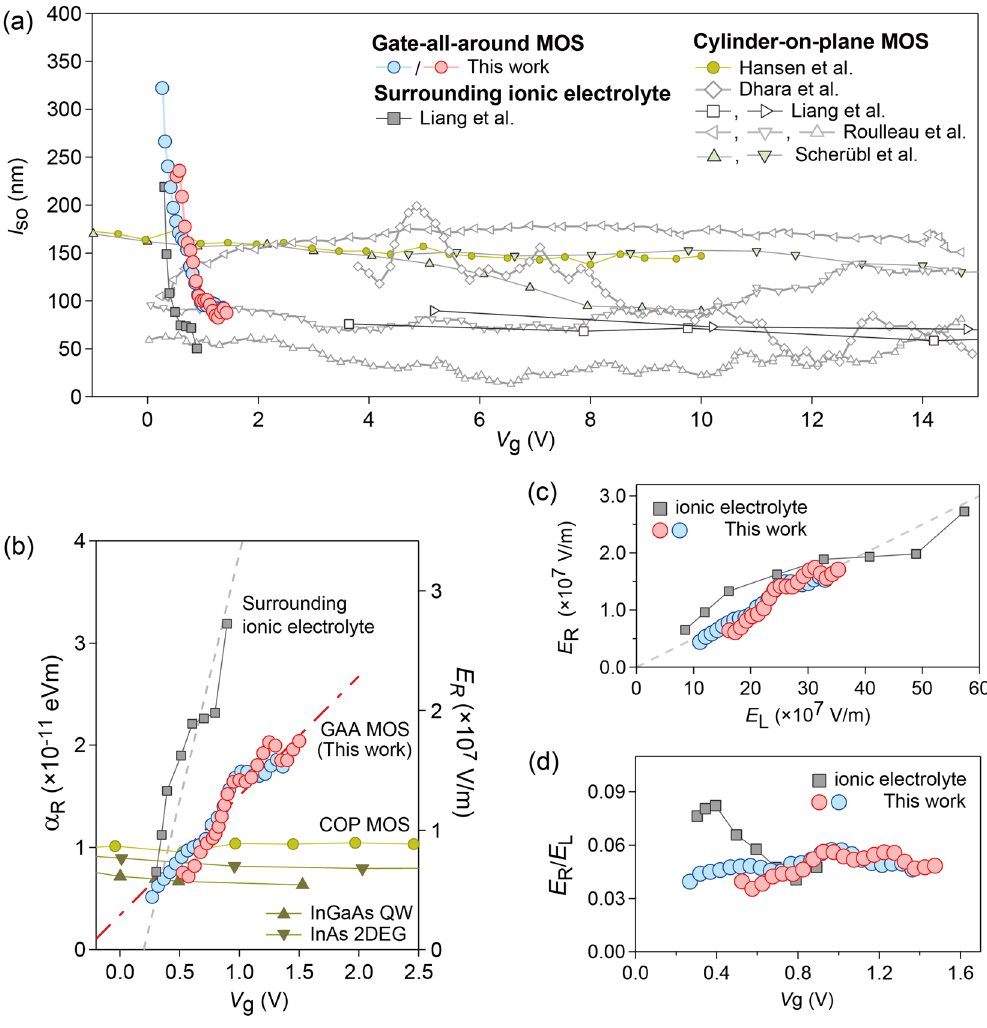
Figure 5. ( a ) Comparison of V g dependence of l so in our device and those in previously reported InAs nanowire devices. They are categorized as having GAA geometry and back- and/or top-gate (cylinder-on-plane) geometry. ( b ) Rashba parameter α R and associated electric field E R plotted as a function of V g for our GAA InAs nanowire MOSFET, an InAs nanowire device using electrolyte 17 , an InAs nanowire device using a back- gate with cylinder-on-plane (COP) geometry 13 , InGaAs QW 8 , and InAs 2DEG used to develop a spin FET 7 . Data shown with red and blue symbols were obtained from measurement runs for the first cooling and for the cooling after 6 months interval in Fig. 3. ( c ) E R as a function of E L for our device and that in ref. 17. ( d ) E R to E L ratio as a function of V g for our device and that in ref.